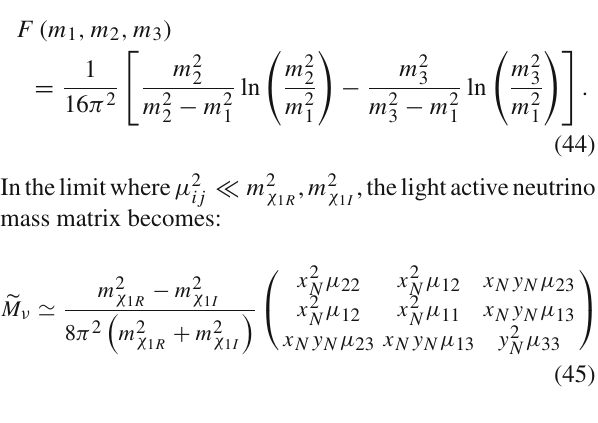
with the loop function of the form